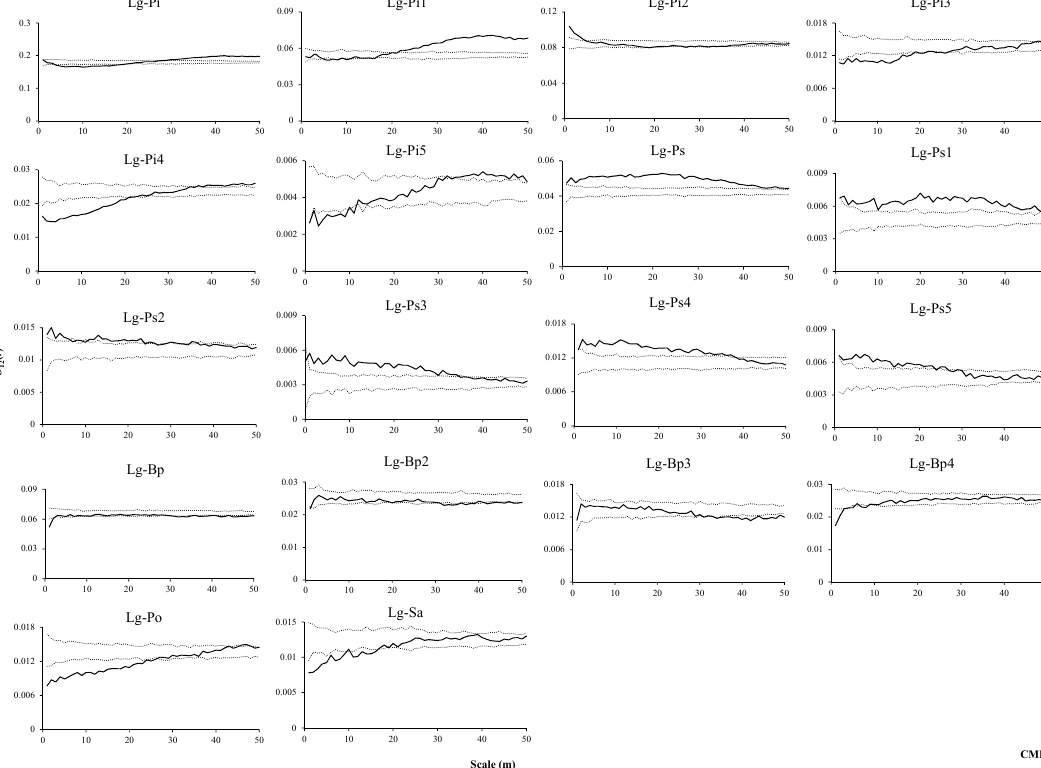
Figure 10. Spatial associations between L. gmelinii and other tree species in CMF.